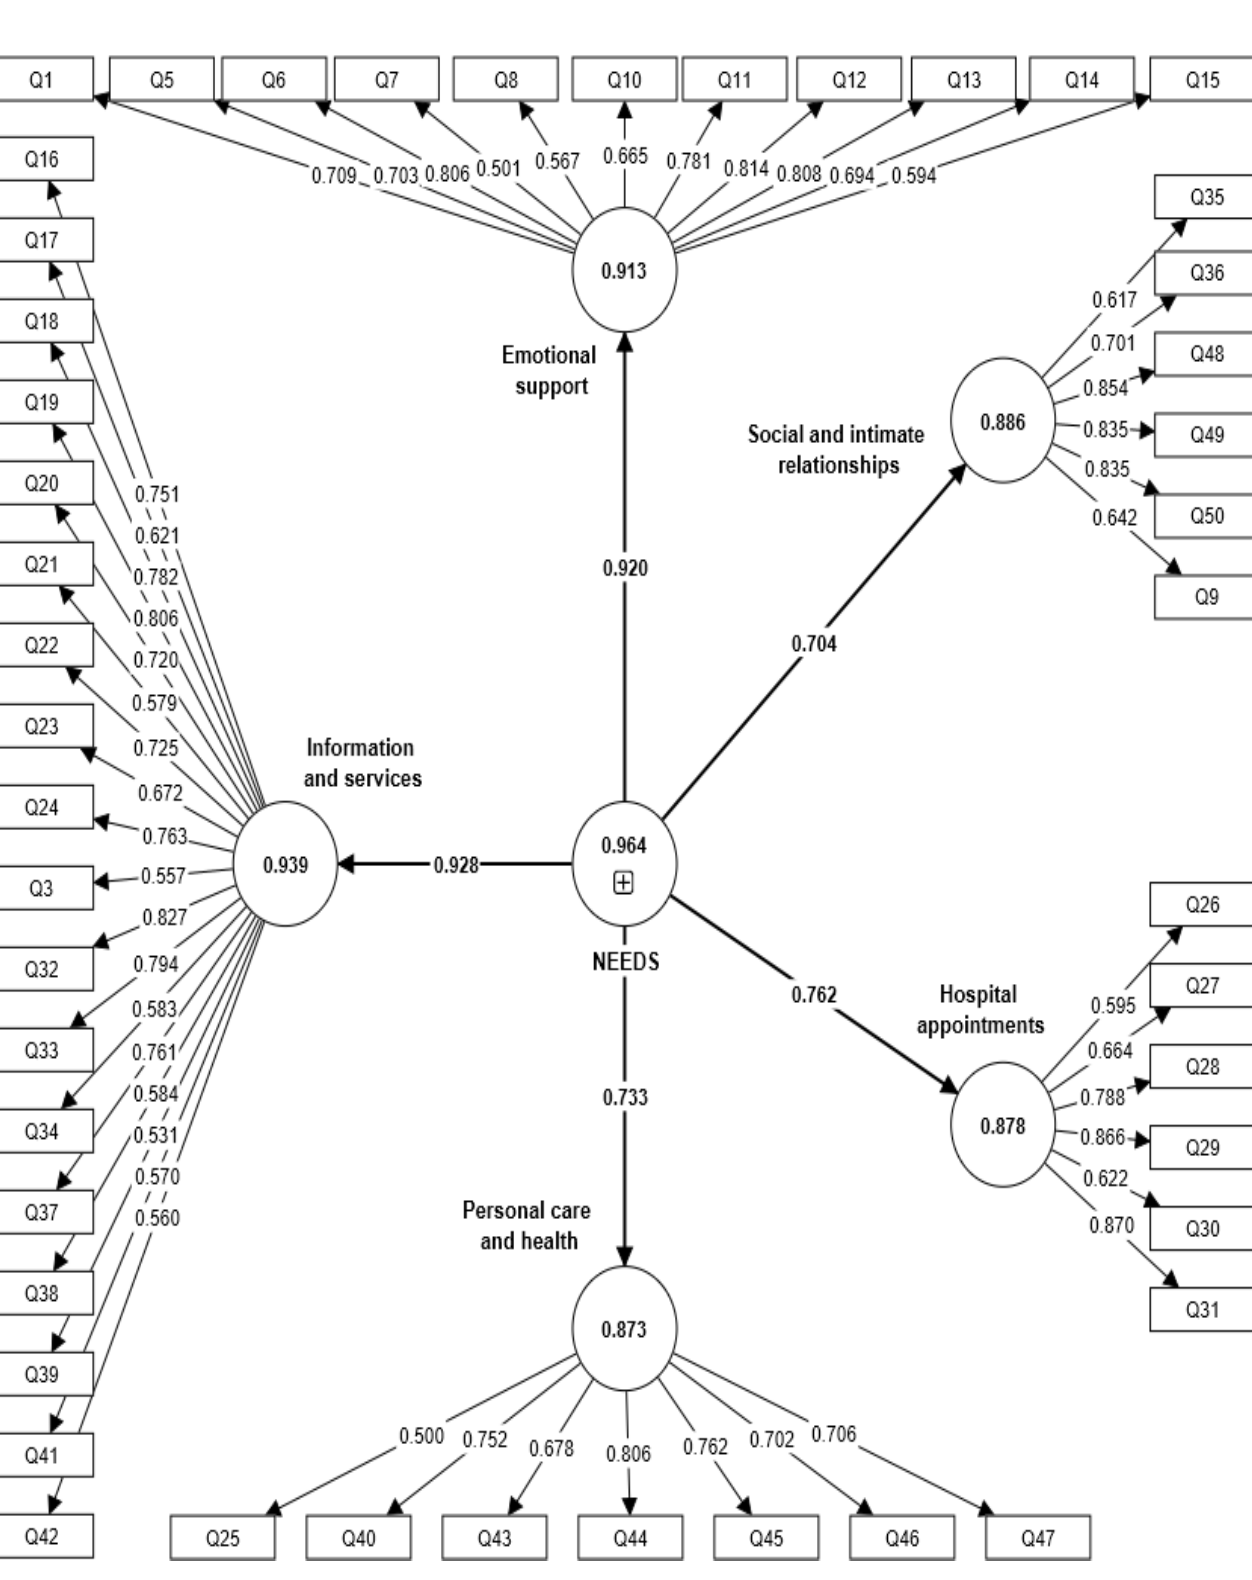
Figure 1. Confirmatory factory analysis (CFA) model of the needs assessment tool for breast cancer (NeAT-BC) using the partial least square — structural equation modelling (PLS-SEM) approach. Table 5. Confirmatory factor analysis of the needs assessment tool for breast cancer (NeAT-BC) using PLS-SEM approach.